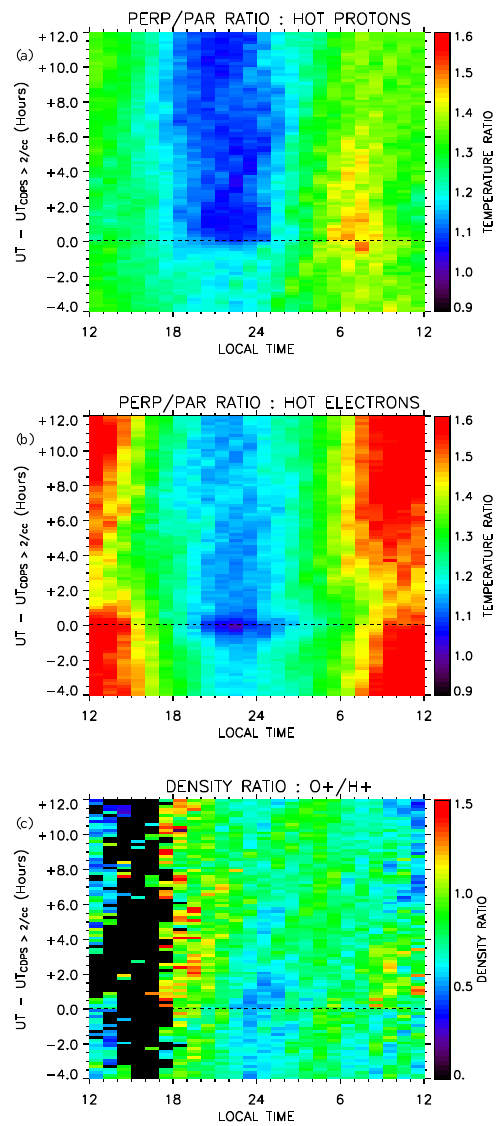
Fig. 4. Results of the superposed epoch analysis for various plasma parameters, similar to Fig. 2. (a) Superposed epoch plot of the perpendicular-to-parallel ion temperature ratio. (b) Superposed epoch plot of the perpendicular-to-parallel electron temperature ra- tio. (c) Superposed epoch plot of the inferred O + /H + density ratio. Respective color palettes are given on the right side of each plot. See text for further